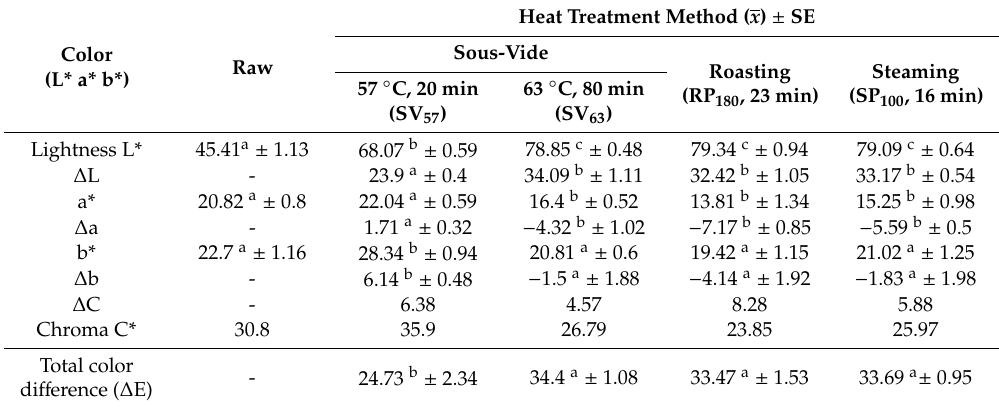
Table 5. Color comparison of salmon of raw and processed with various heat treatment